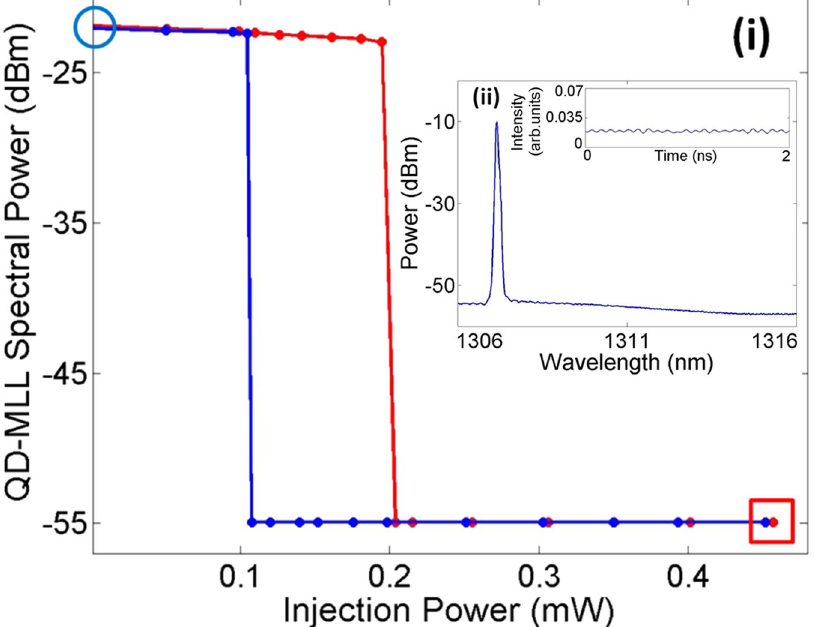
Figure 3. (i) QDMLL’s spectral peak power vs optical input power for increasing (red) and decreasing (blue) injection strength. A plot of the measured spectra (ii) and time series (inset) for the operating point marked by a red square in the curves of (i). The QDMLL is biased with 77.3 mA (gain section), − 2.5 V (absorber section) and kept at 293 K. The external optical signal is injected at the wavelength of 1307.18